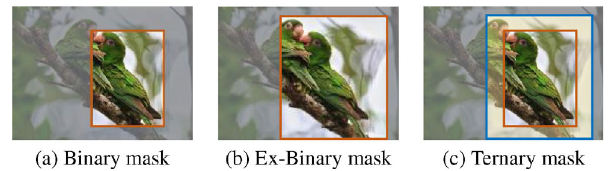
Fig. 5 Three different types of masks used in our RoIMasking layer. (a) The binary mask only considers the regions inside the orange rectangle, (b) the expanded binary mask considers a larger rectangle than binary masking, and (c) the ternary mask takes into account both the region inside the orange rectangle and the surrounding regions marked in